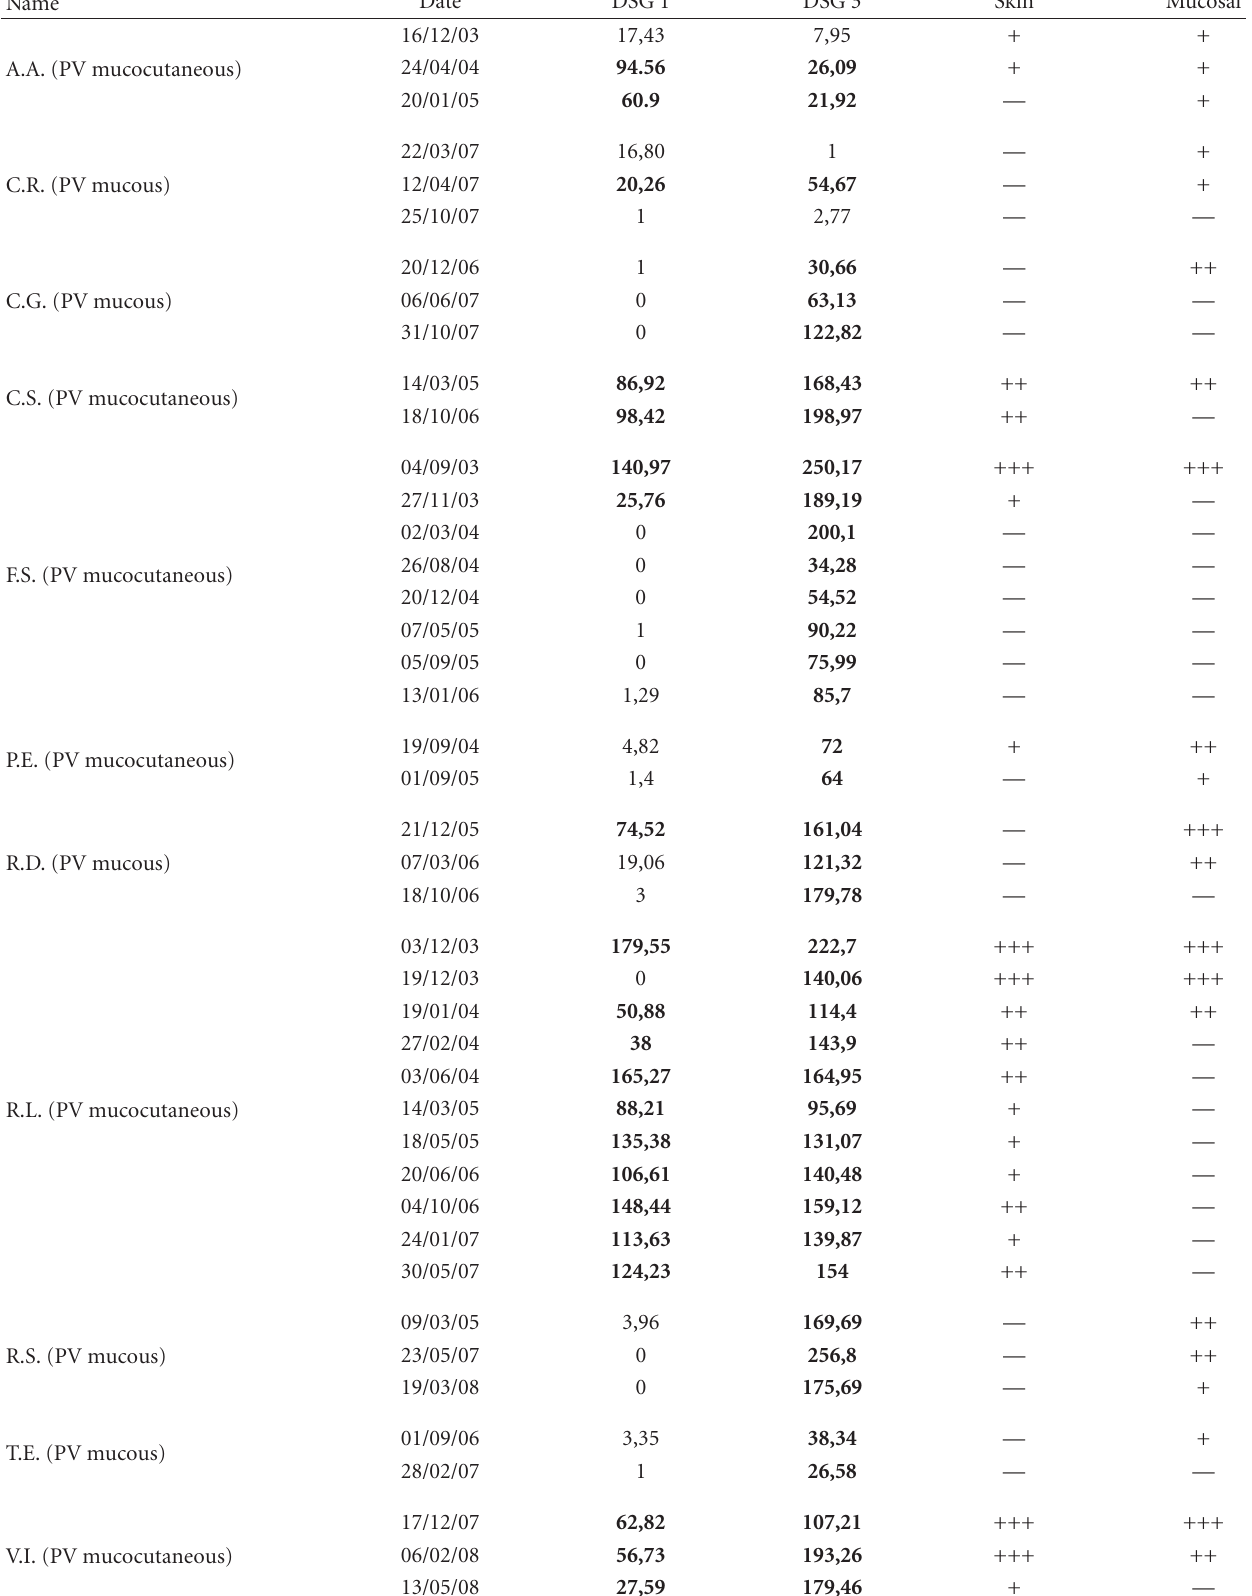
Table 3: Autoantibodies titres during follow-up. Values above the cuto ff point of 20 Unit/mL are indicated in